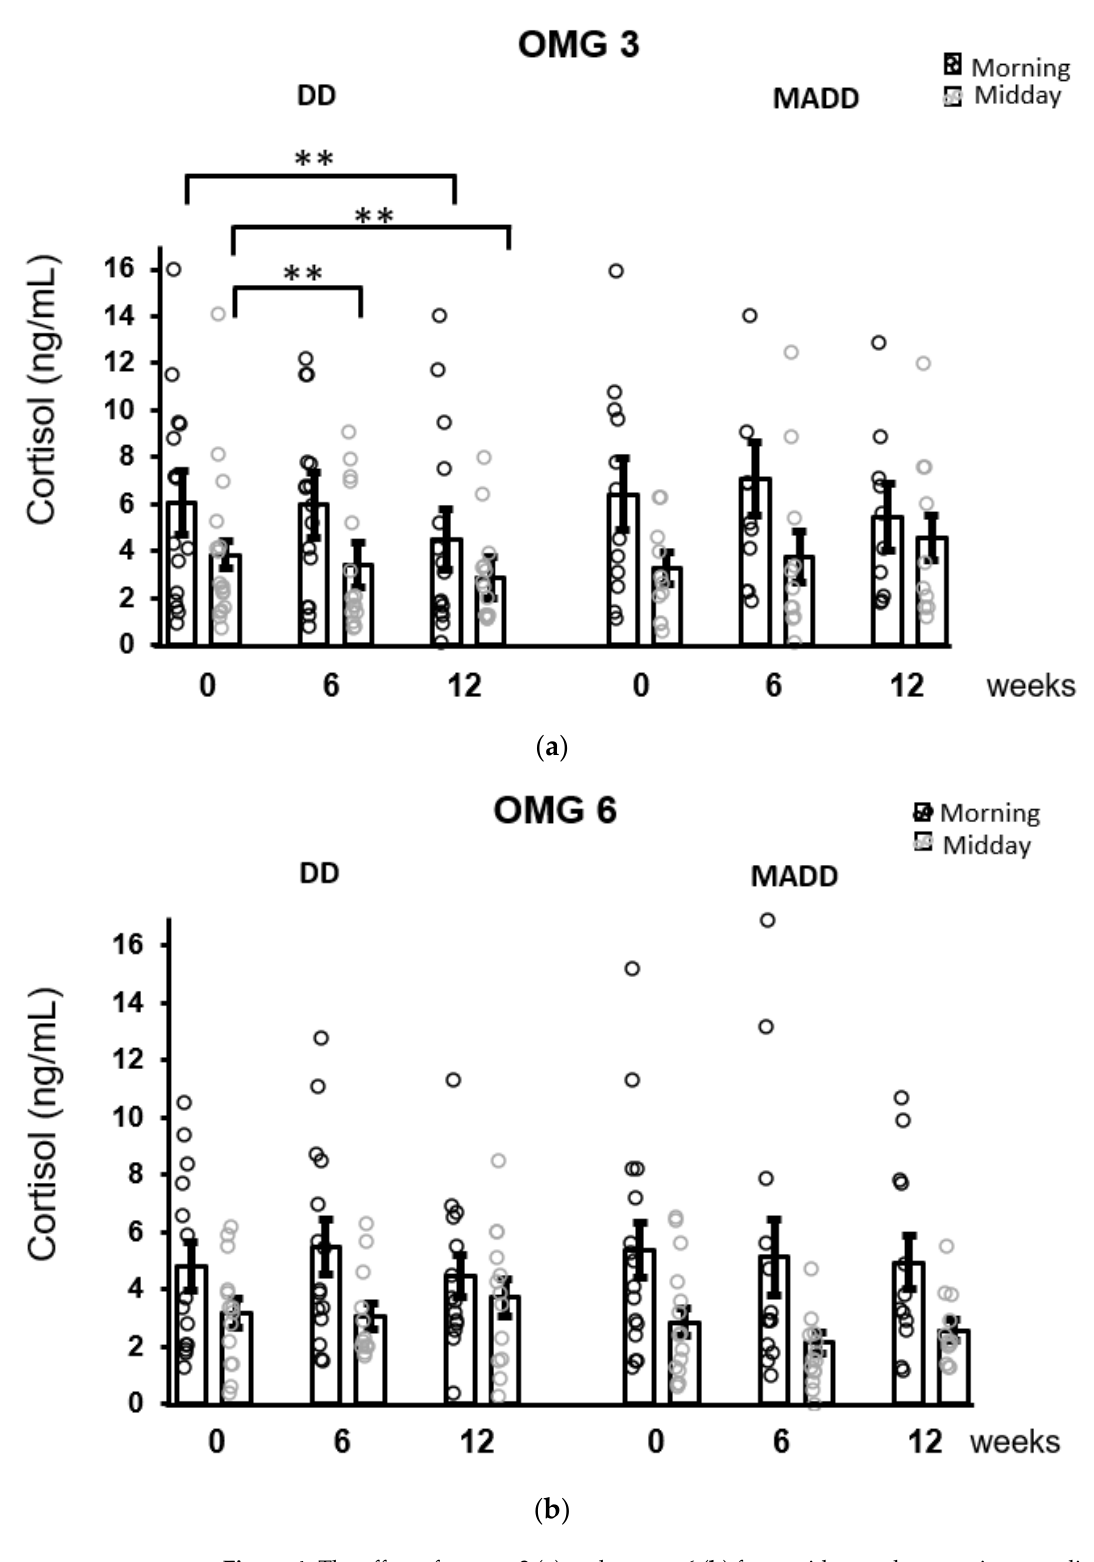
Figure 4. The effect of omega-3 ( a ) and omega-6 ( b ) fatty acids supplementation on salivary cortisol concentrations after stratification of patients according to the diagnoses. Decreases in morning and midday cortisol concentrations as revealed by Conover pairwise comparison test: ** p < 0.01. Results are expressed as dot plots with each dot representing an individual subject with means ± SEM. DD — depressive disorder subgroup and MADD — mixed anxiety and depressive disorder subgroup.